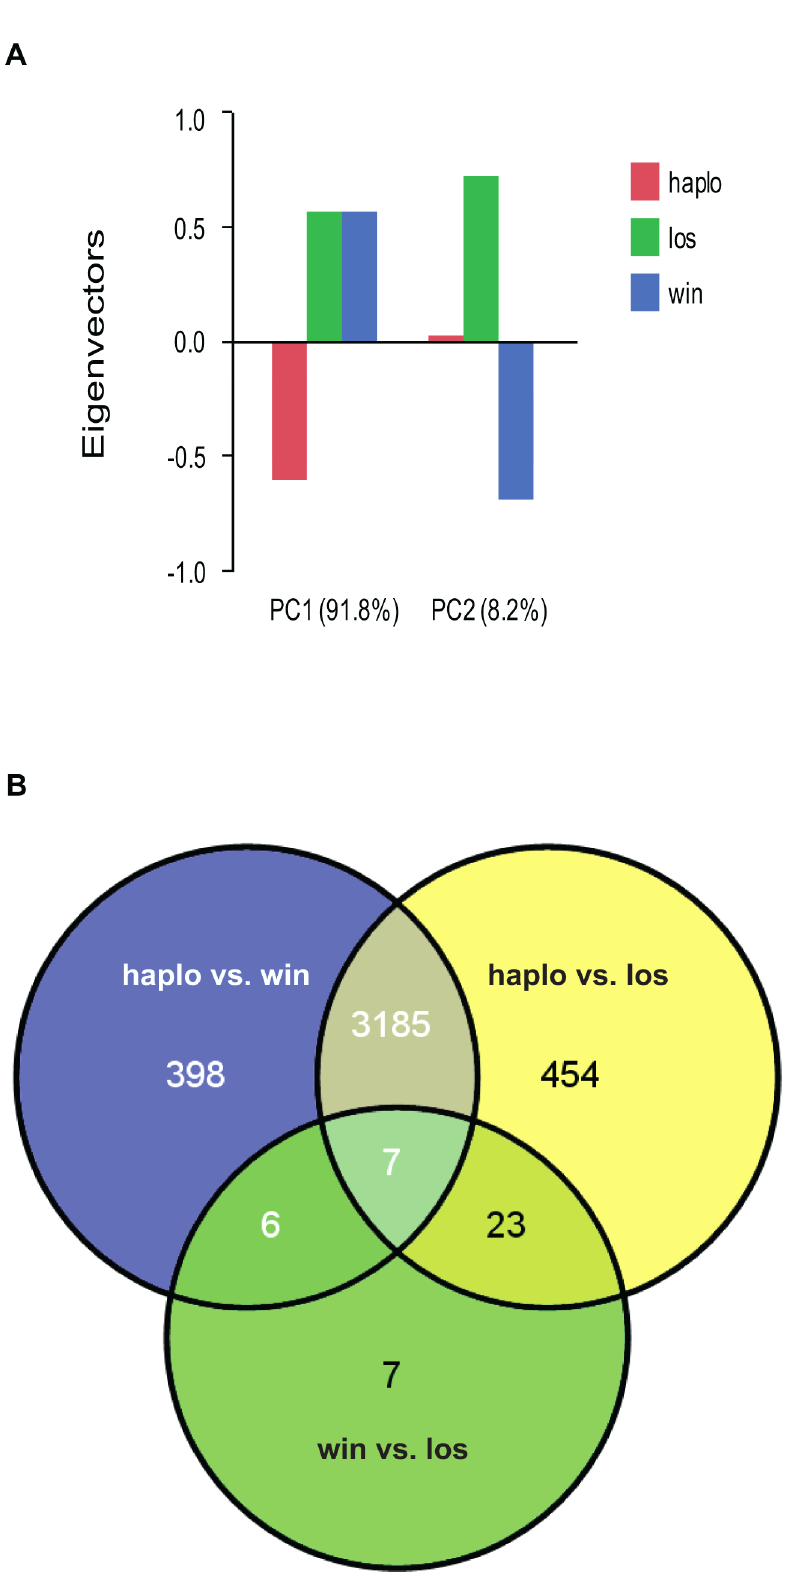
Figure 1. Analyses of global gene expression between haplometrotic and pleometrotic queens. A) Principal Component Analysis of 4080 significantly differentially regulated transcripts. Two PCAs were identified corresponding to the effect of social environment (single queen vs. paired queens, 91.8%) and social rank (winner vs. loser, 8.2%). B) Pairwise comparisons of 4080 significantly differentially regulated transcripts. A total of 3192 transcripts were different between haplometrotic and pleometrotic queens, while only 43 transcripts were different between winner and losers. Haplometrotic queens were more similar to pleometrotic winners than to pleometrotic losers: more transcripts were differentially regulated in haplo